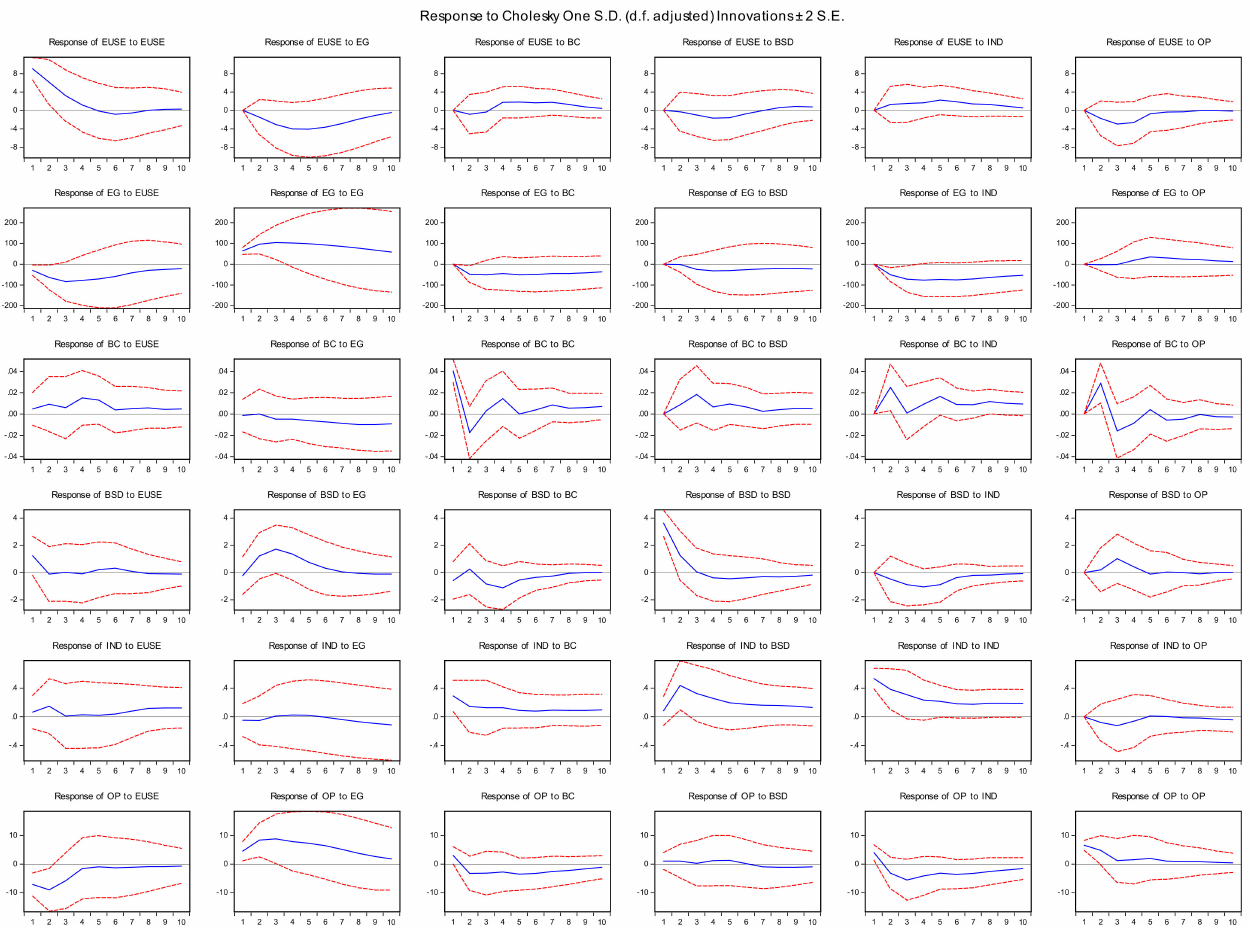
Figure 1. Impulse response function. Blue line is impact line and shows the impact, however upper and lower red doted lines are upper and lower